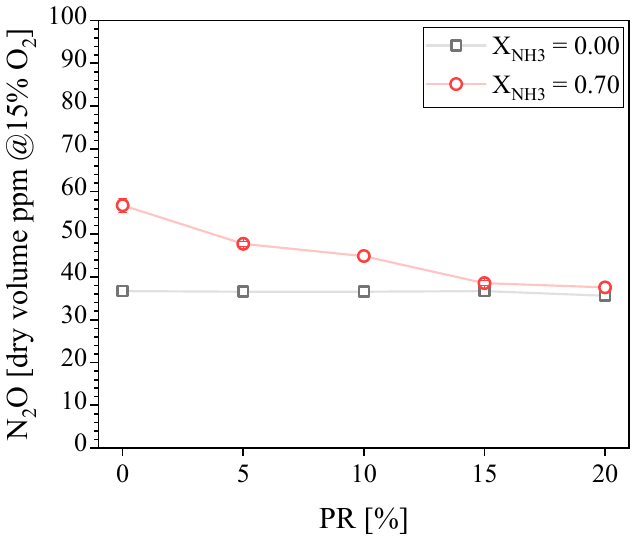
Figure 7. Measured N 2 O concentration in the exhaust gases as a function of the PR.